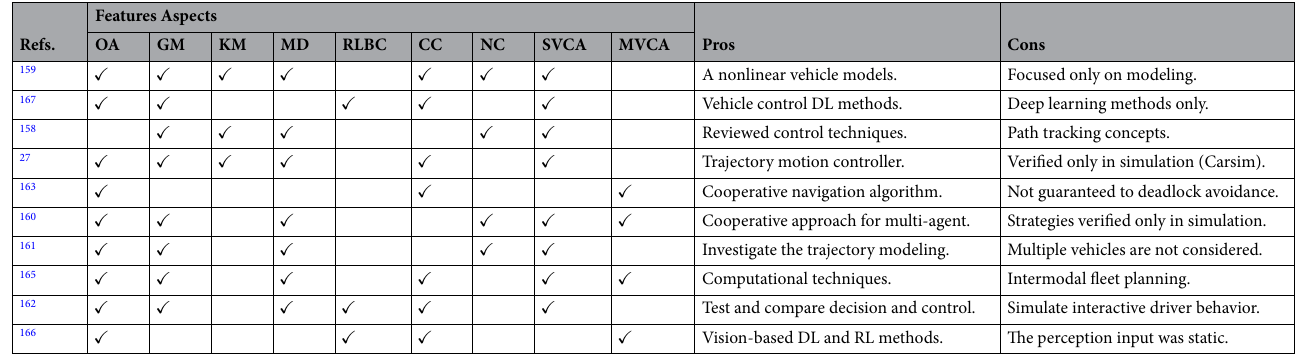
Table 8. According to latest works the major features of vehicle control for MVCCA in AVs. OA Obstacle avoidance, GM Geometric model, KM Kinematic model, DM Dynamic model, RLBC RL based control, CC Cooperative control, NC Non-cooperative control, SVCA Single vehicle collision avoidance, MVCA Multiple vehicle collision avoidance.